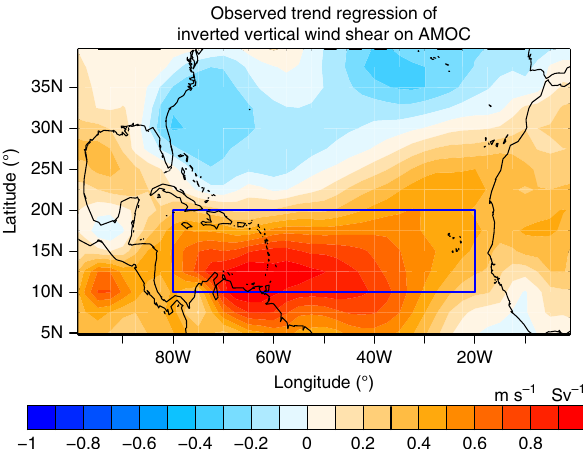
Fig. 3 Observed trend regression of inverted vertical wind shear on the AMOC Index. The 11-year trends of inverted vertical shear of zonal wind are regressed on the 11-year trends of AMOC Index at 26°N. The observed AMOC Index at 26°N is reconstructed using the AMOC fi ngerprint (Methods). Blue box: Atlantic hurricane main development region (MDR: 80°W – 20°W, 10°N – 20°N). The results are based on all available 11-year segments sampled from the observations. Positive values imply an increase in vertical wind shear when AMOC declines, and vice